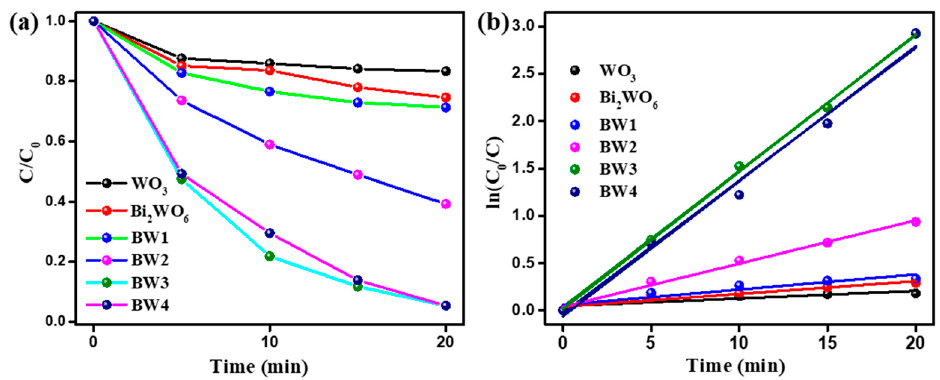
Figure 9. The influence of stoichiometric ratios of Bi and W in the composites for the BPA degradation ( a ), and the corresponding degradation kinetics of BPA ( b ). Reaction condition: initial BPA concentration of 10 mg/L, PMS dosage of 0.1 mmol/L, catalyst addition of 1 g/L.